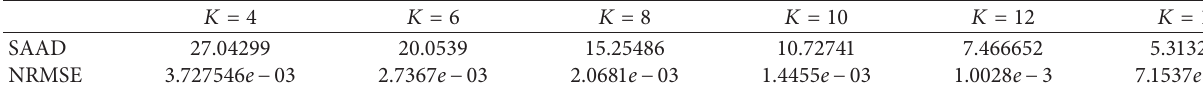
Table 7: Evaluation metrics for different variational mode